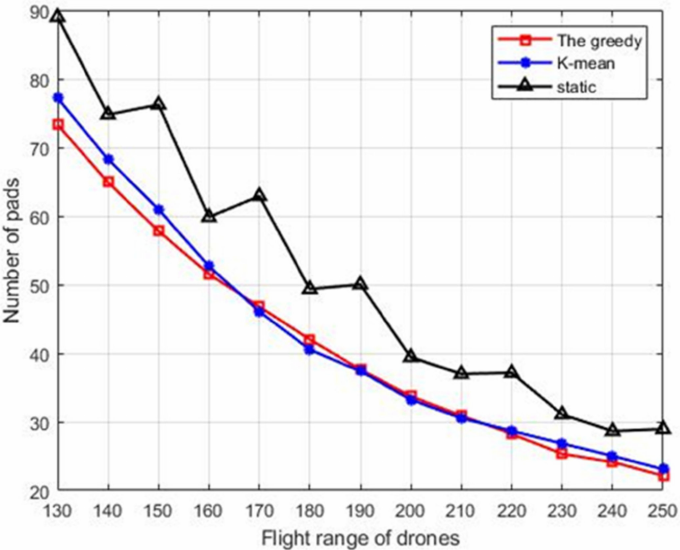
Figure 11. Comparison of the number of pads when the flight range changes.